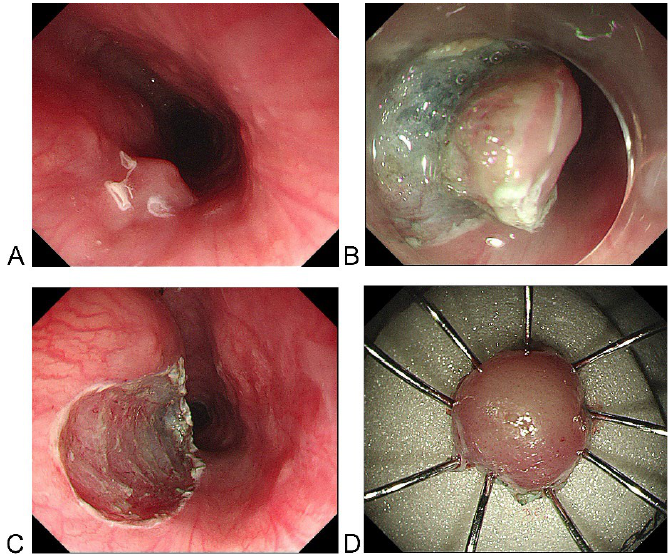
Figure 2. The process of endoscopic submucosal dissection: the lesion is removed en bloc. ( A ) The outer margin of the lesion. ( B ) Submucosal dissection. ( C ) Wound after dissection. ( D ) Specimen. Histology revealed a well-defined lesion between the lamina propria and submucosa (Figure 3A). It was composed of lymphoepithelial crypts lined by stratified squamous mucosa with infiltrating lymphocytes and histocytes, similar to the tonsillar structure of WR (Figure 3B). CD3+ T-cell zone and CD20+ B-cell-rich follicles were seen on immuno- histochemistry (Figure 4A,B). Scattered PD-L1-positive lymphocytes and histocytes were observed. The epithelium was negative for PD-L1 (Figure 4C). P16 was negative in both lymphocytes and epithelium (Figure 4D). The patient’s swallowing discomfort was significantly improved at 1 month, and the esophagoscopy at 6 months showed no evidence of recurrence.